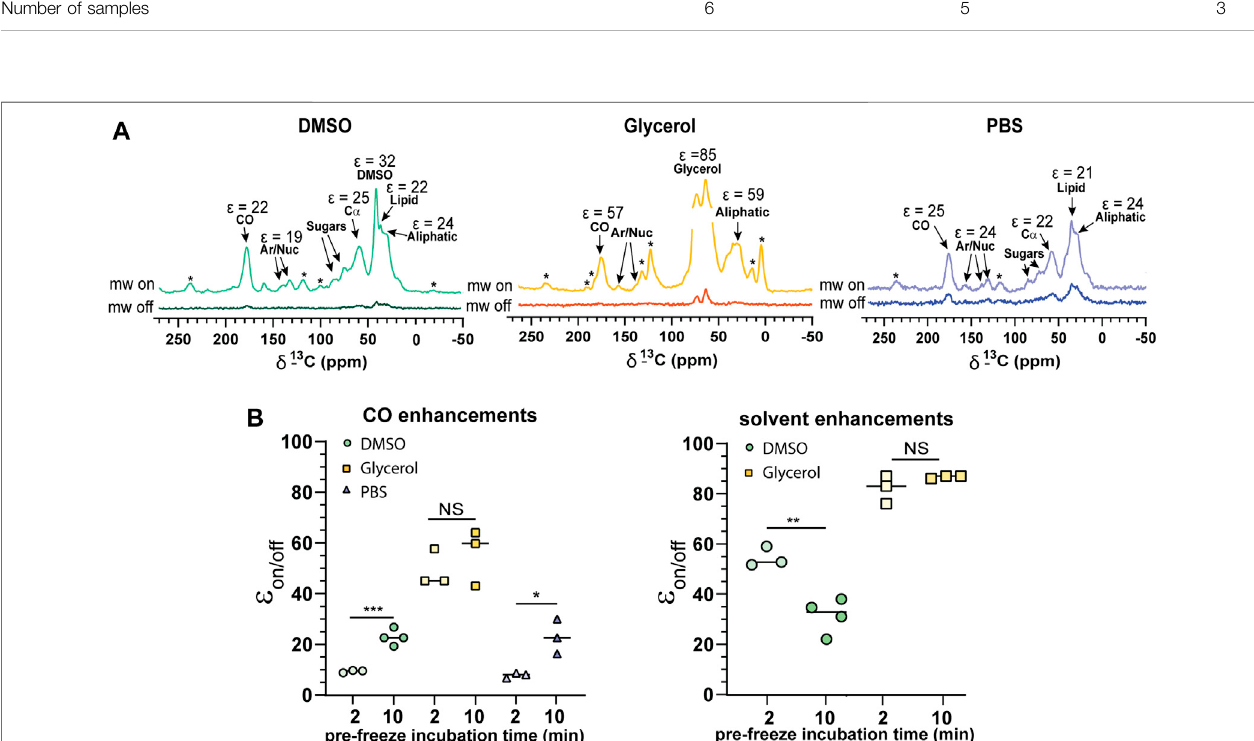
FIGURE 3 | Cellular penetration of AMUPol in Jurkat T cells. (A) Comparison of 1 H- 13 C CP spectra of 10% DMSO, glycerol, and PBS protected Jurkat T cells. Cellular components and their average enhancements are indicated. Enhancements are given as peak intensity ratios as not all signals could have the ε / √ unit time determined. * indicates spinning side bands. (B) Enhancements obtained after 2 and 10 min incubations with AMUPol prior to fl ash-freezing for CO and solvent peaks. Statistical signi fi cance was determined using a parametric t -test where * (cid:2) p < 0.05, ** (cid:2) p < 0.01 and *** (cid:2) p < 0.001, NS (cid:2) not signi fi cant. DNP experiments were carried out at 600 MHz 1 H larmor frequency at 9 kHz